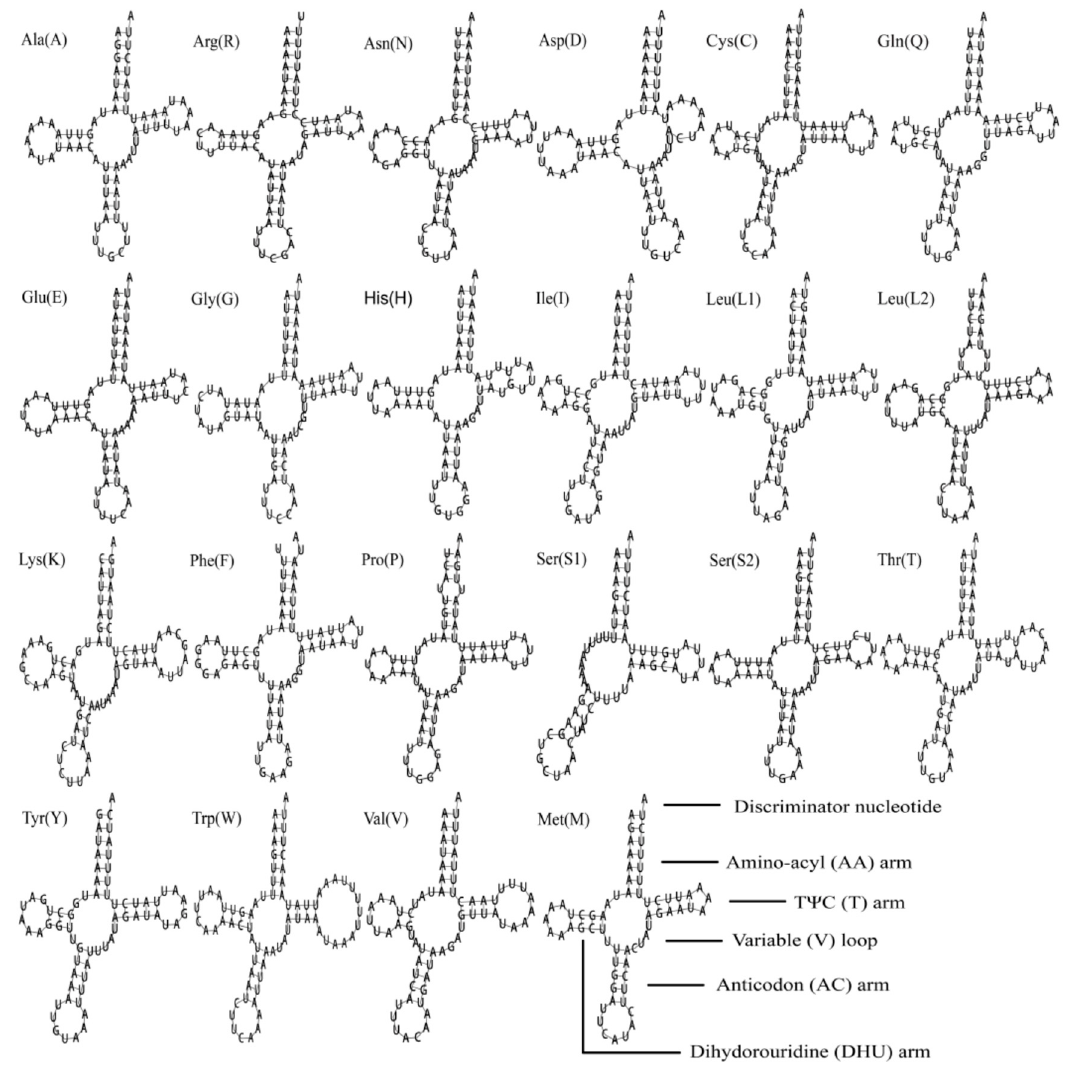
Figure 6. Secondary structures of the transfer RNA genes (tRNAs) in Stomaphis sinisalicis mitogenome.